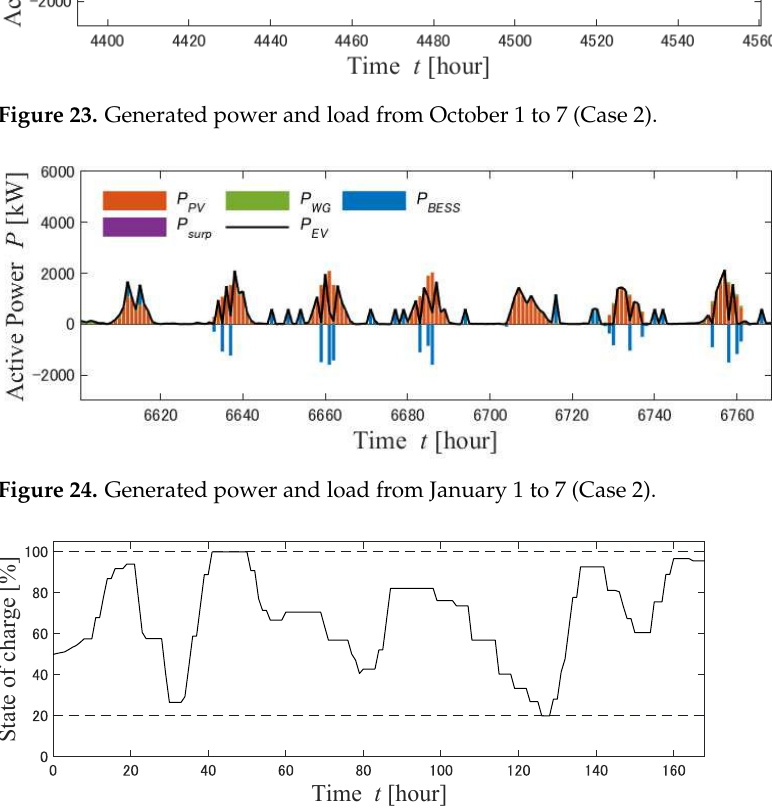
Figure 25. SOC of BESS from April 1 to 7 (Case